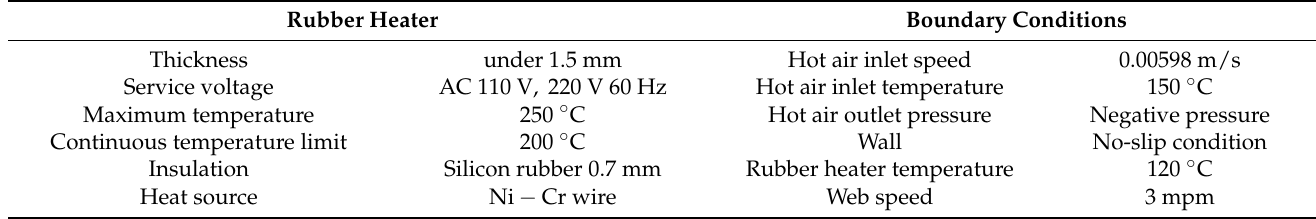
Figure 6. Schematic of the rubber heater and boundary conditions for the dryer simulation. Table 2. Specifications of the rubber heater and boundary conditions for the dryer simulation